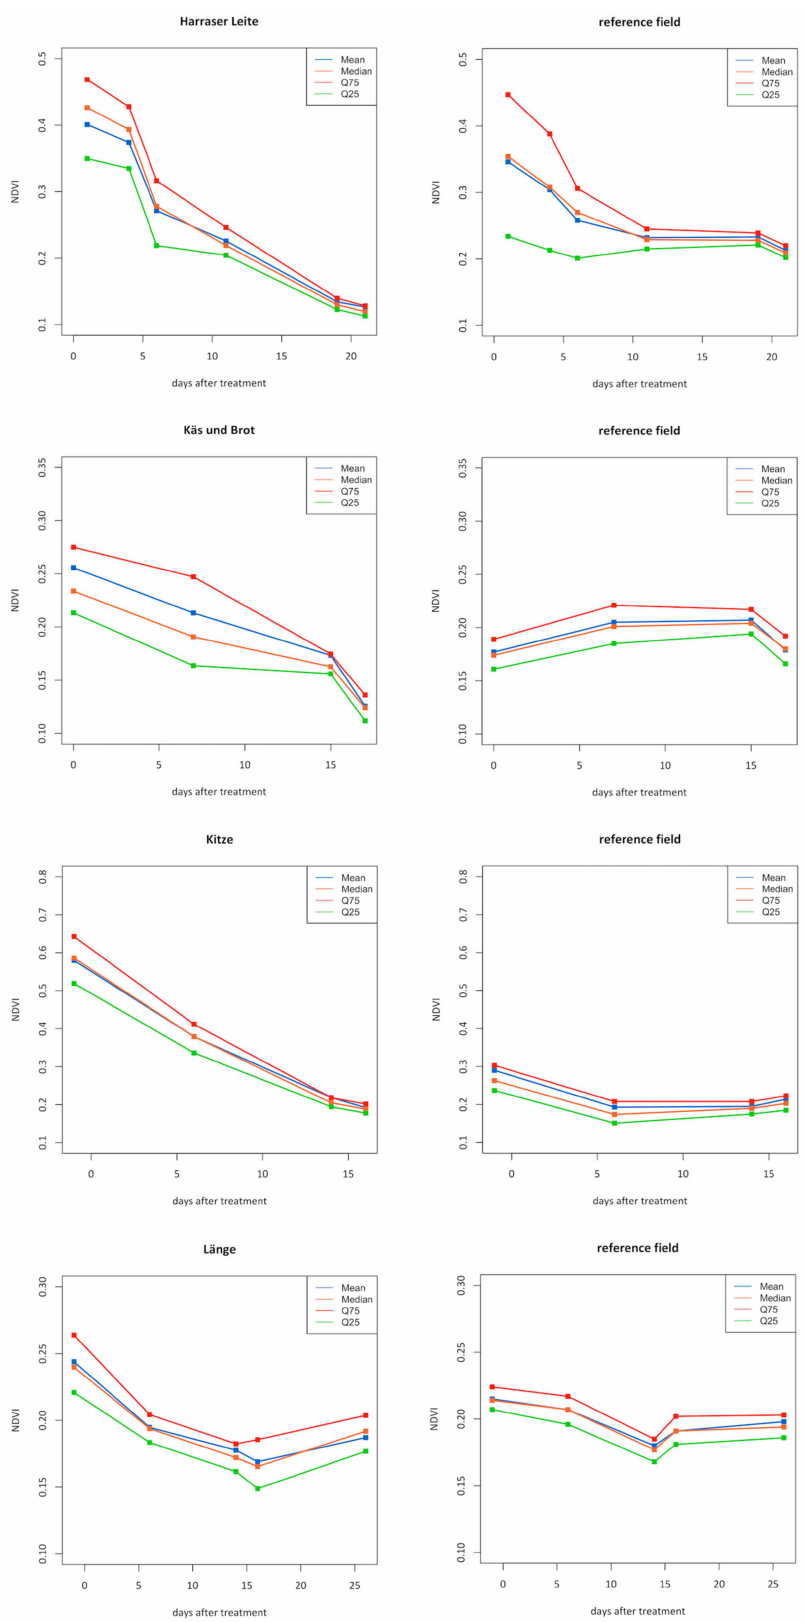
Figure 6. Temporal dynamic of NDVI values for the sites treated with herbicide and appropriate reference sites without herbicide treatment. Day 0 indicates the day of herbicide treatment in the case of the test sites